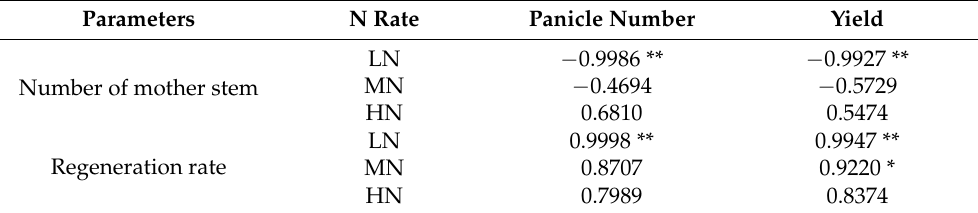
Table 5. Effects of N regime in the main crop on the yield components of the ratoon crop. Parameters N Rate Panicle Number